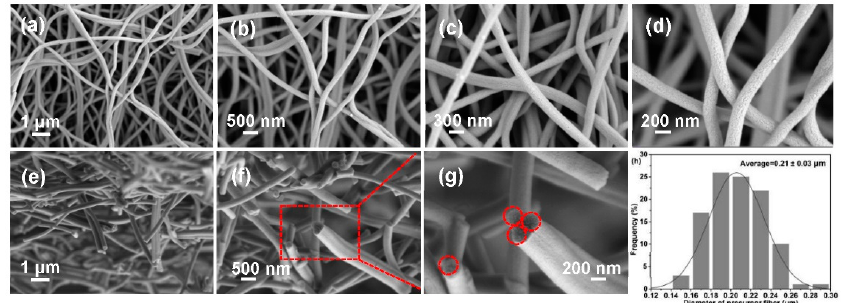
Figure 7. SEM images of ( a – d ) surfaces and ( e – g ) cross ‐ sections of CFs, and ( h ) their diameter dis ‐ tribution diagram. dis-tribution